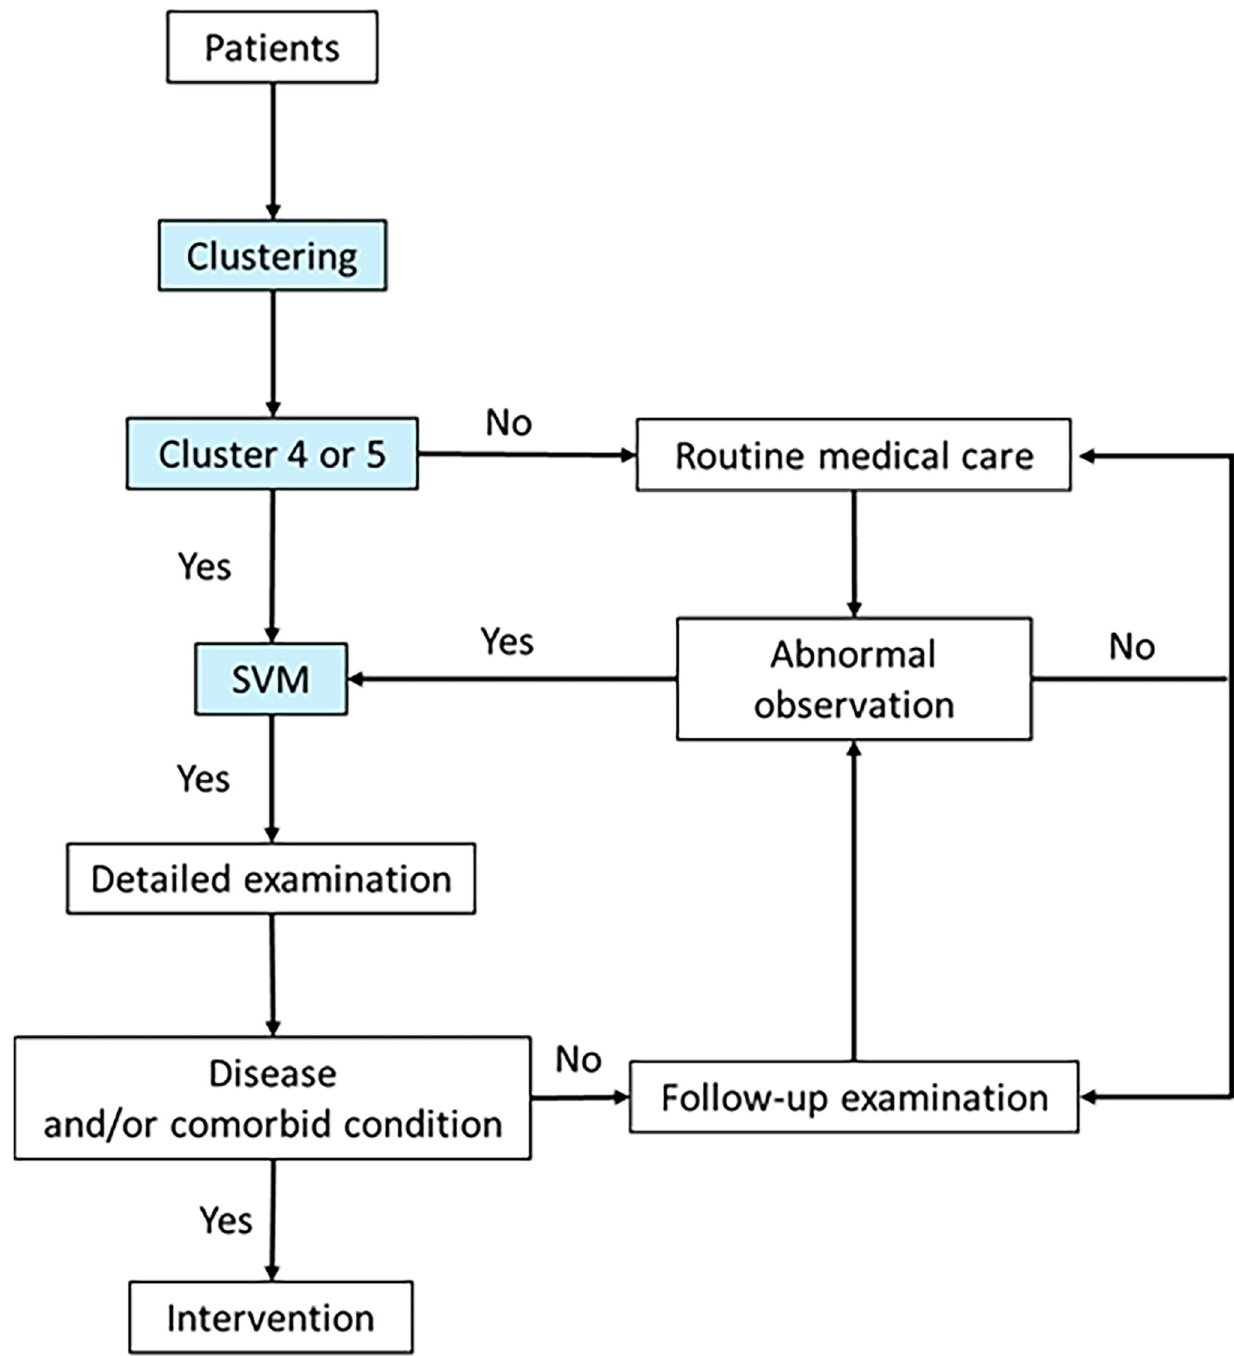
Fig 12. Diagnostic system using ensemble model. Our system is as follows: a. Extract high-risk patients (Clusters 4 and 5) on the basis of sensitivity, specificity, and characteristics of the clusters. b. Examine in detail patients in Clusters 4 and 5 using SVM models, and routinely follow up depending on their risk of death. The blue part can be examined using the ensemble model. Abbreviation: SVM, support vector machine models. factors for all-cause and CVD-caused deaths [18]. In our study, no clear differences were